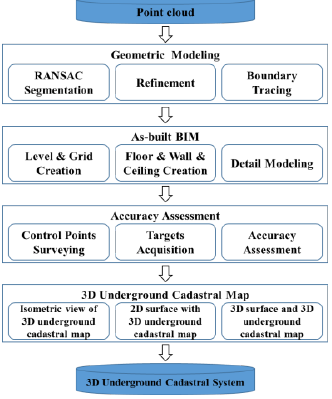
Figure 1. Overall procedure of proposed method.